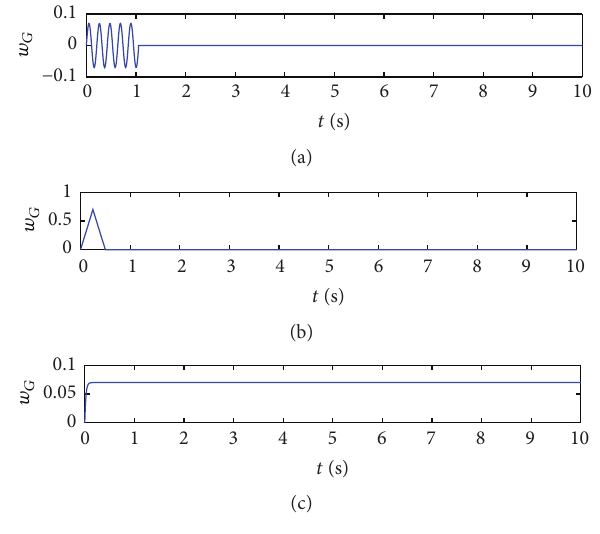
Figure 2: External disturbances: (a) sinusoidal gust; (b) triangular gust; (c) graded